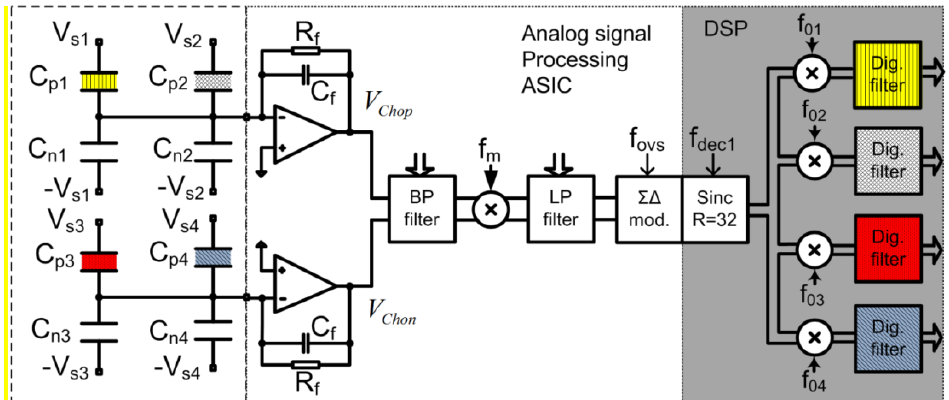
Figure 12. Signal processing block diagram of the low noise electronic measurement system that can process signals from four differently modified